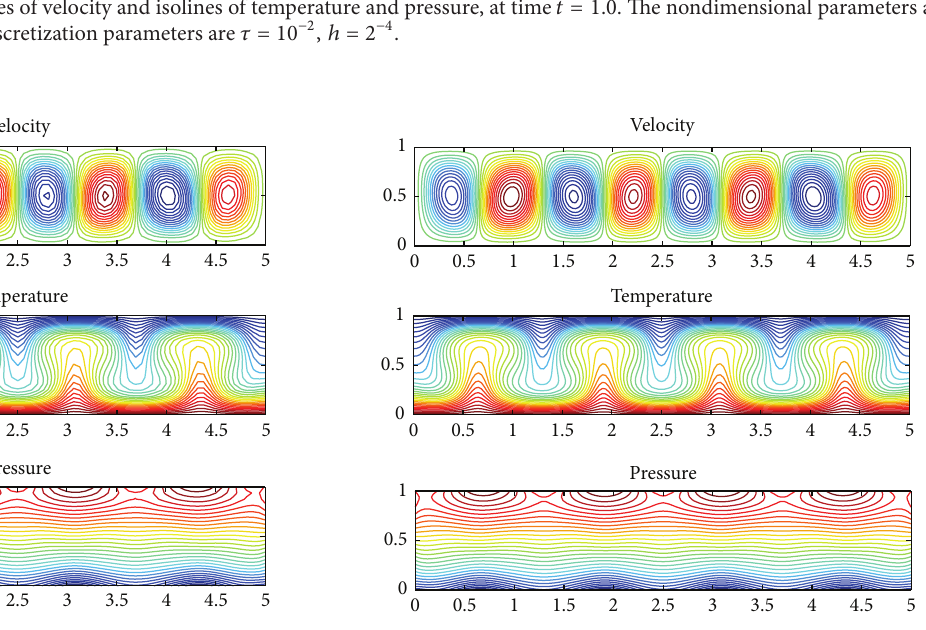
Figure 4: Example 20: streamlines of velocity and isolines of temperature and pressure, at time 𝑡 = 1.0 . The nondimensional parameters are 𝜅 = 10 4 ,𝜆 = 1 , and 𝜇 = 1 , and the discretization parameters are 𝜏 = 10 −4 , ℎ = 2 −6 .